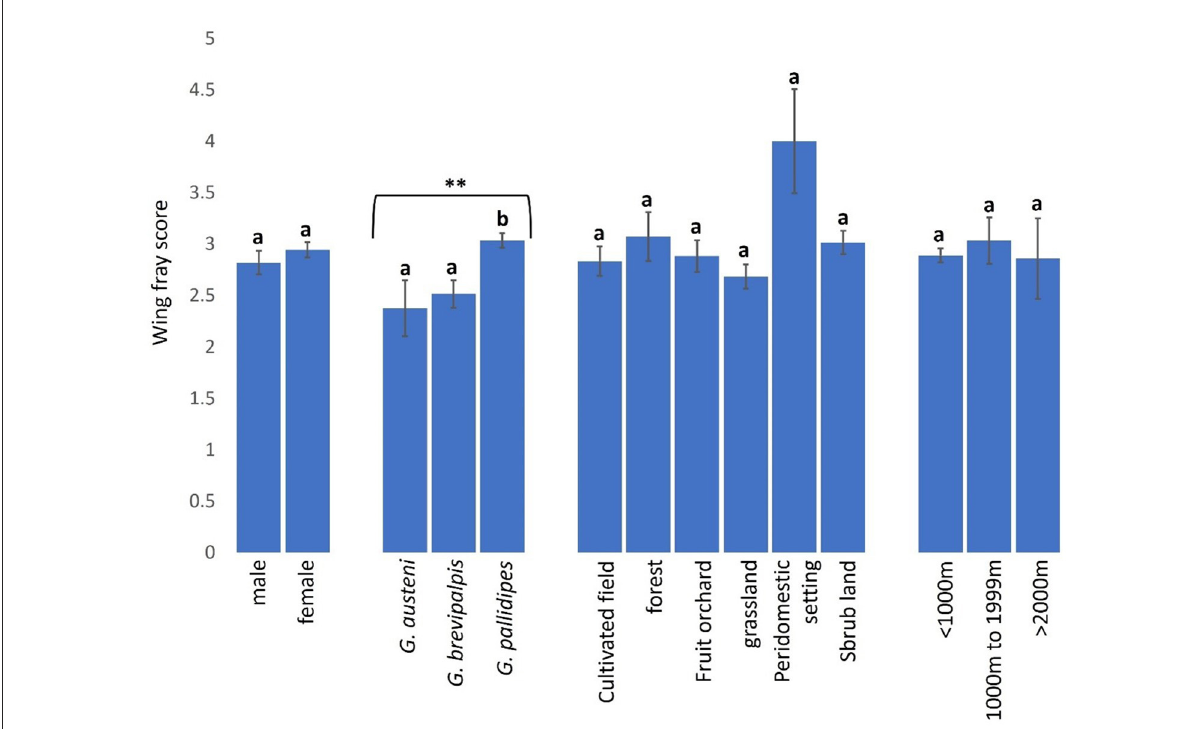
FIGURE8 Wing fray scores of tsetse flies according to fly sex and species and collection site. Error bars are used to indicate the standard error of the mean (SEM). Letters have been used to indicate presence or absence of significant difference in pairwise comparisons of tsetse fly wing fray scores. Pairwise comparisons are made between tsetse flies within the same group defined by sex, species, vegetation site or distance from the wildlife reserve. Significantly different pairs are denoted using different letters while insignificantly different pairs are indicated using same letters.